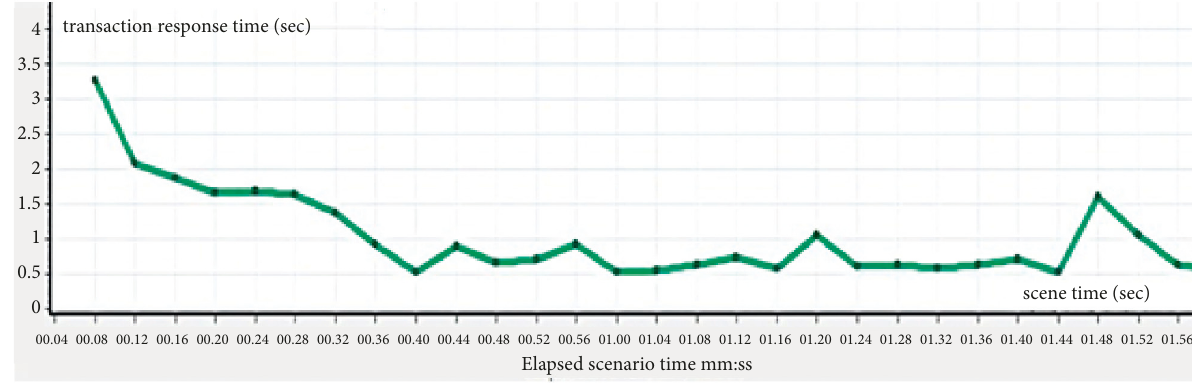
Figure 9: Container mode expansion deployment response time.